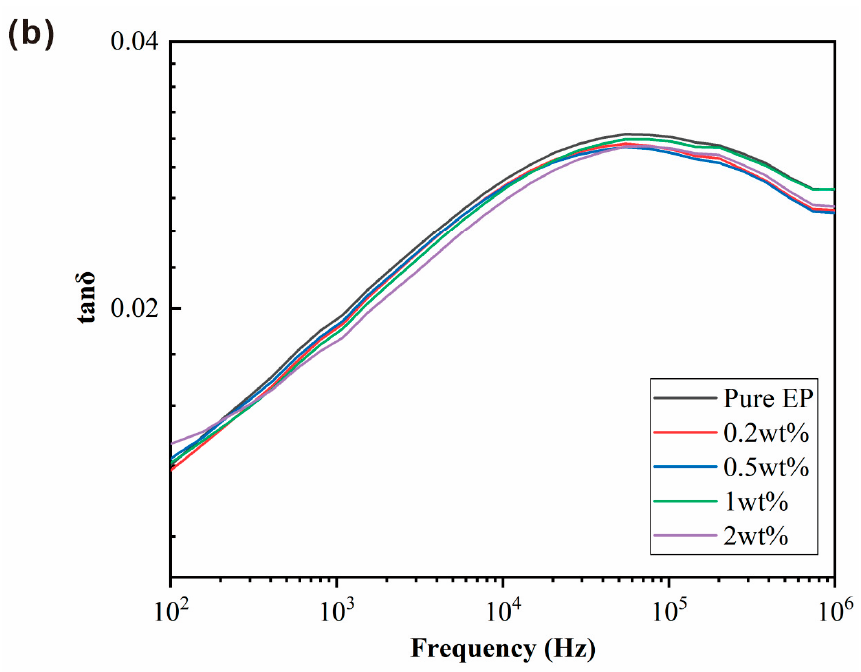
Figure 10. Dielectric constant ( a ) and dielectric loss ( b ) in BPEI-ZIF-8/IL/EP with different addition levels (wt%) of nanofluid.